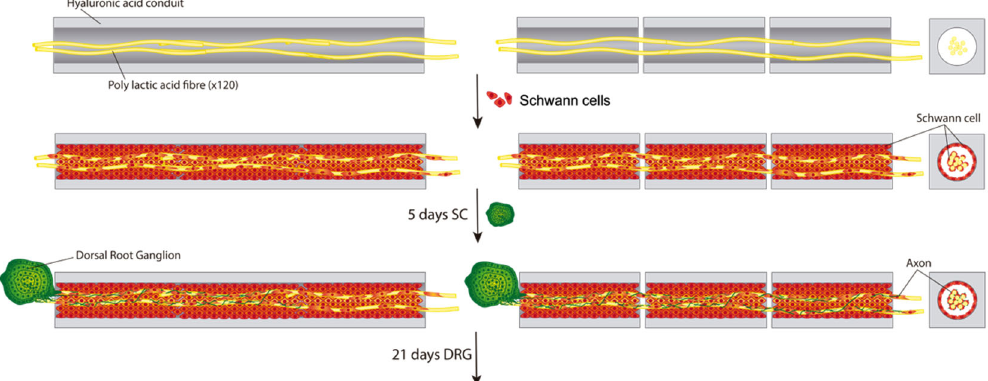
Figure 1. Schematic view of the generation of the long-distance axonal regeneration strategy proposed. Longitudinal and transversal view of a unimodular conduit (left) and multimodular conduit (right) formed by three individual modules of HA and PLA fibers passing through its lumens. We seeded SC for 5 days and the SC formed a tapestry in the inner lumen and also grew on the PLA fibers. After 5 days of SC culture, we seeded a DRG explant at one end of the unimodular and multimodular conduits and culture for 21 days, expecting the axons of projecting neurons extent through the conduits. We observed the axon growth to prove the effectiveness of promoting directed axon growth in long distances.